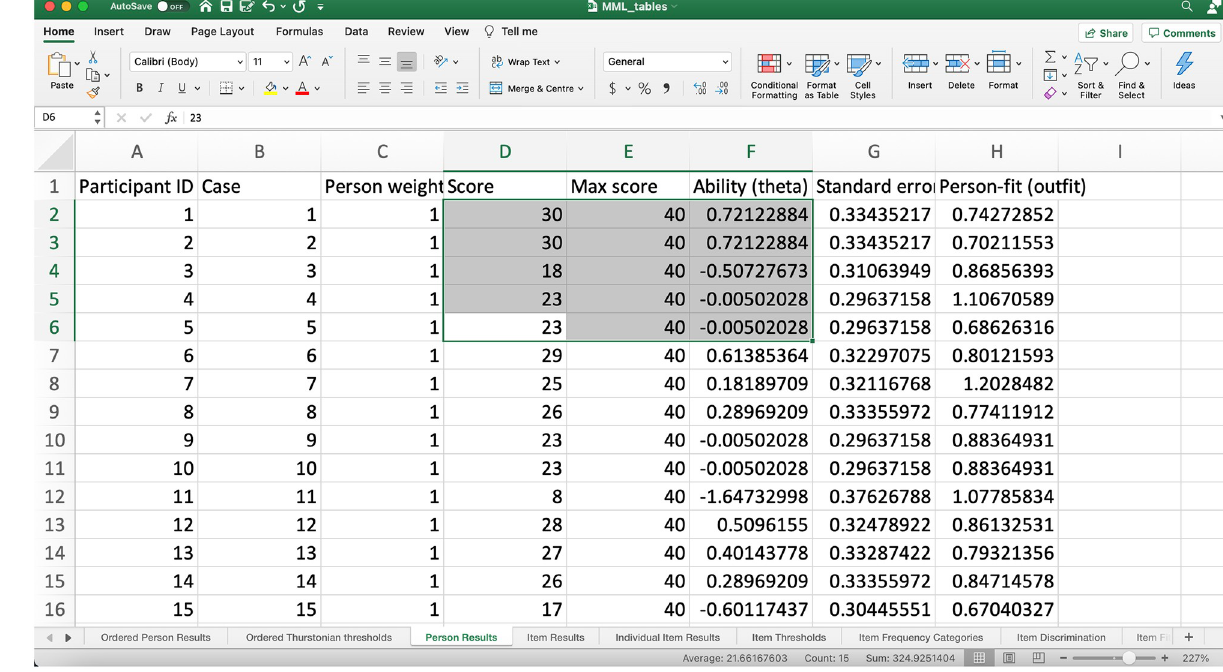
Fig 7. Selection of tabs in output single multi-tabbed spreadsheet. Note. Student Score, Max score, and Ability (theta) is highlighted.